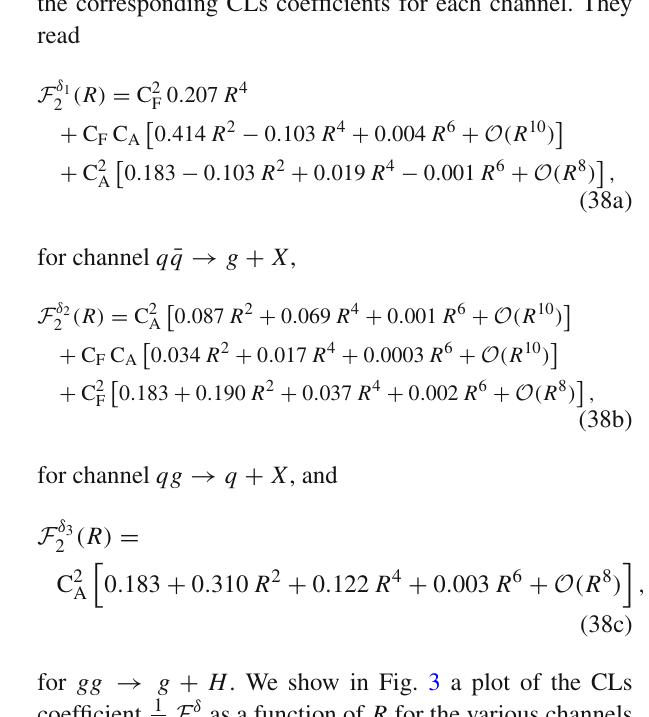
Substituting the results (37) back into Eq. (36) we obtain the corresponding CLs coefficients for each channel.